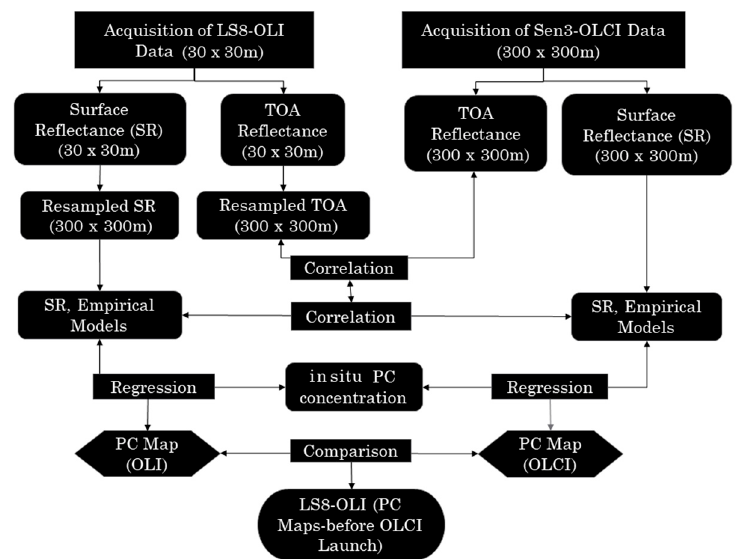
Figure 2. Overall schematic diagram of processing steps for Landsat 8 (LS8) OLI and Sentinel 3 (Sen3)-Ocean and Land Color Instrument (OLCI) data in this study. PC: phycocyanin; SR: surface reflectance; TOA: top-of-atmosphere.